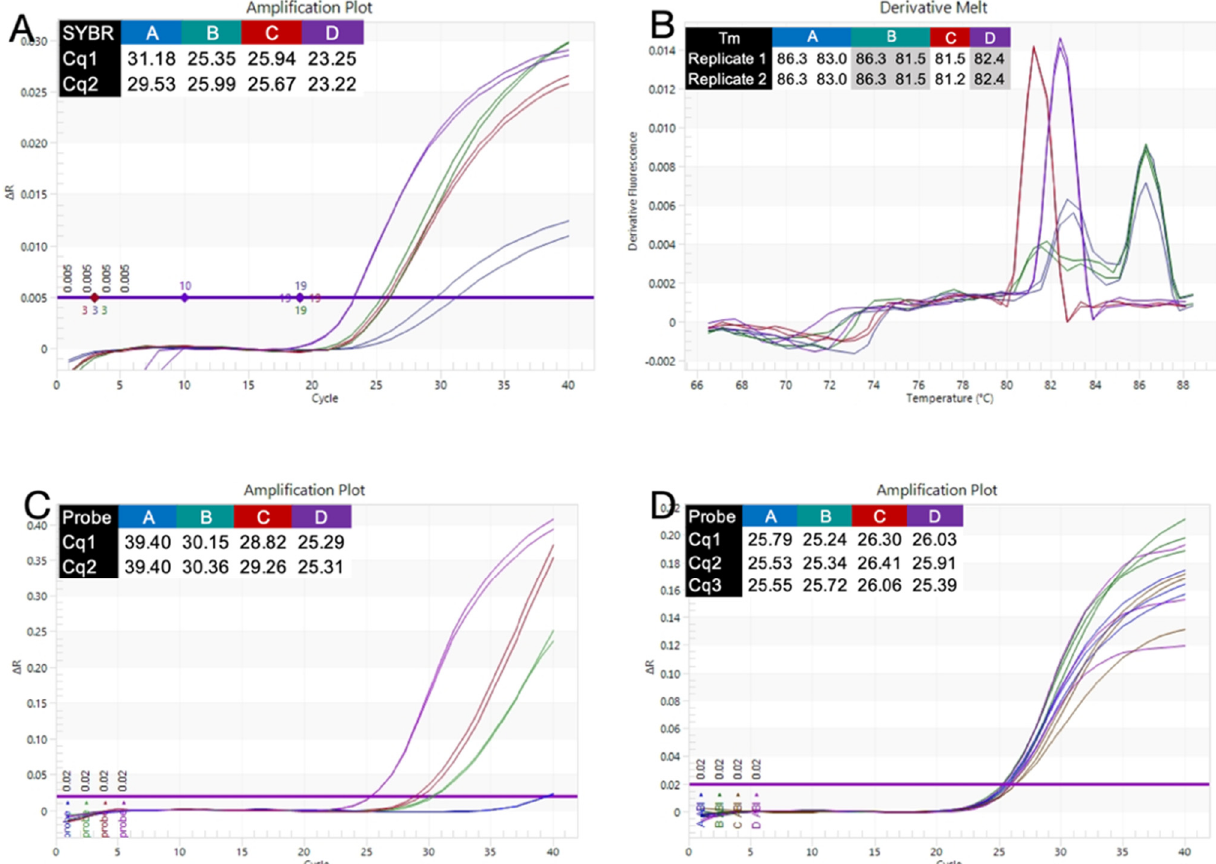
Figure 4. Amplification of assays A (blue), B (green), C (brown) and D (purple) with MM-5. ( A ). Cq values and amplification plots recorded with MM-5 master mix with a 20 s polymerisation step. ( B ). Tms and melt curves for each of the four assays. Assay A has two distinct peaks and assay B has a leading shoulder. ( C ). Cq values and amplification plots following the addition of hydrolysis probes with a 20 s polymerisation step. ( D ). C q values and amplification plots following the addition of hydrolysis probes with a 60 s polymerisation